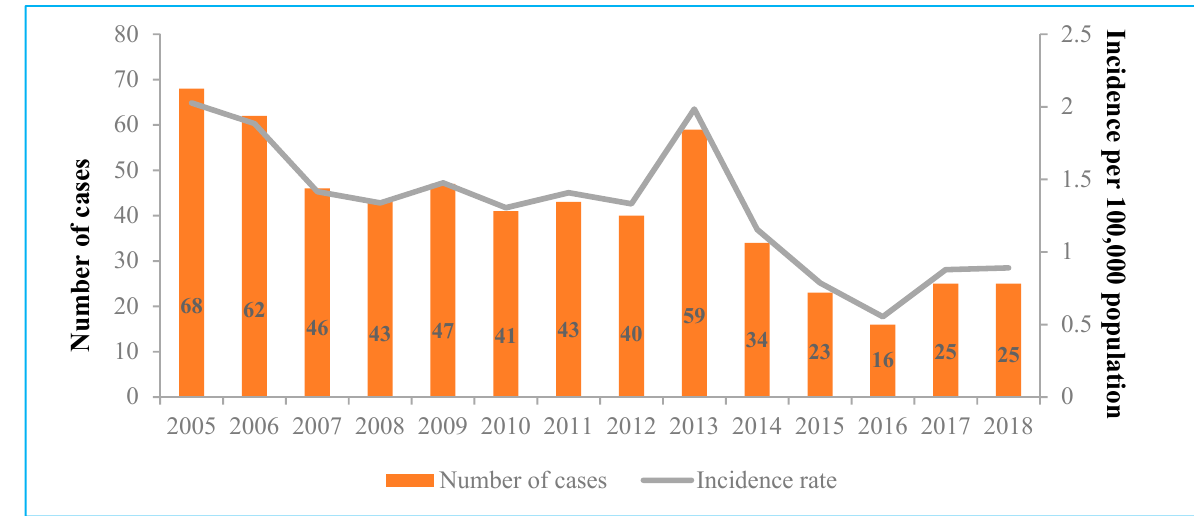
Figure 1. Number and incidence rates of acute hepatitis C virus cases notified via the national surveillance system, Lithuania, 2005–2018.